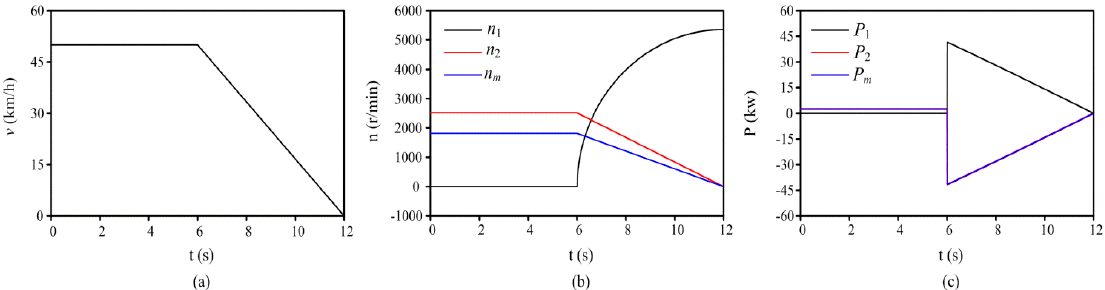
Figure 7. Mode 2: ( a ) Required vehicle velocity; ( b ) Rotational speeds; ( c ) Powers.